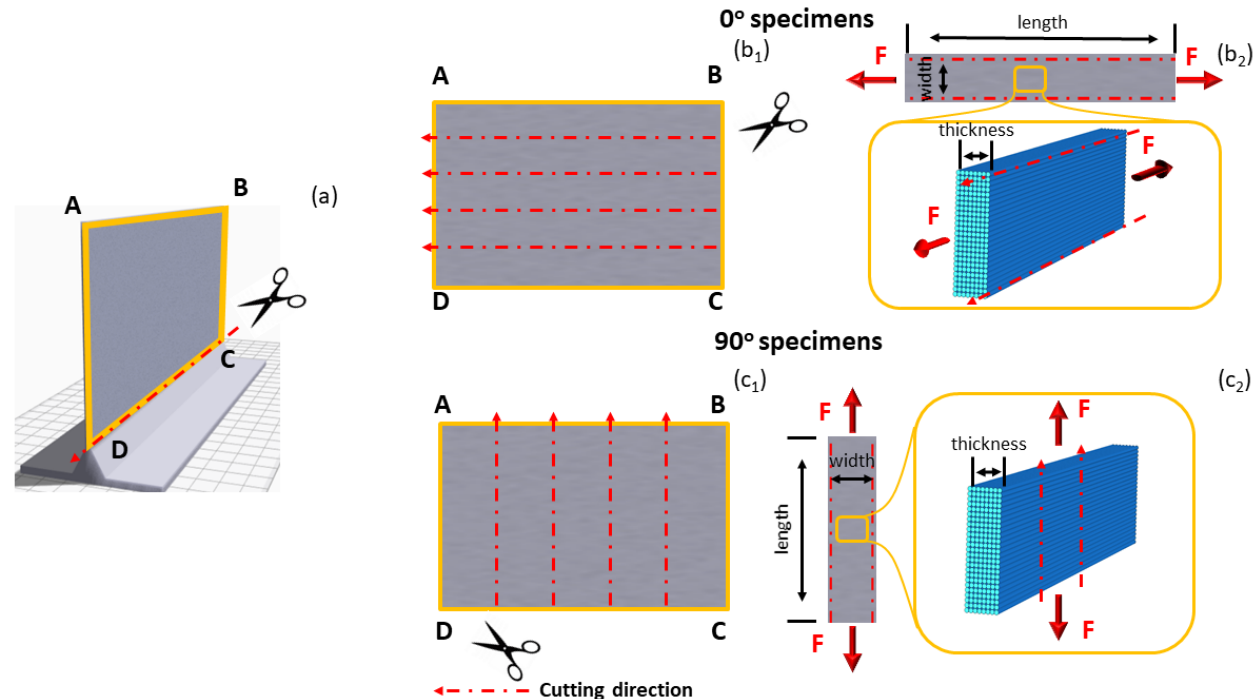
Figure 3. Preparation of the 0° and 90° specimens: ( a ) removal of the base; ( b 1 , c 1 ) the cutting direction of the 0° and 90° specimens, respectively; ( b 2 , c 2 ) the loading direction and internal printing pattern of the 0° and 90° specimens, respectively.